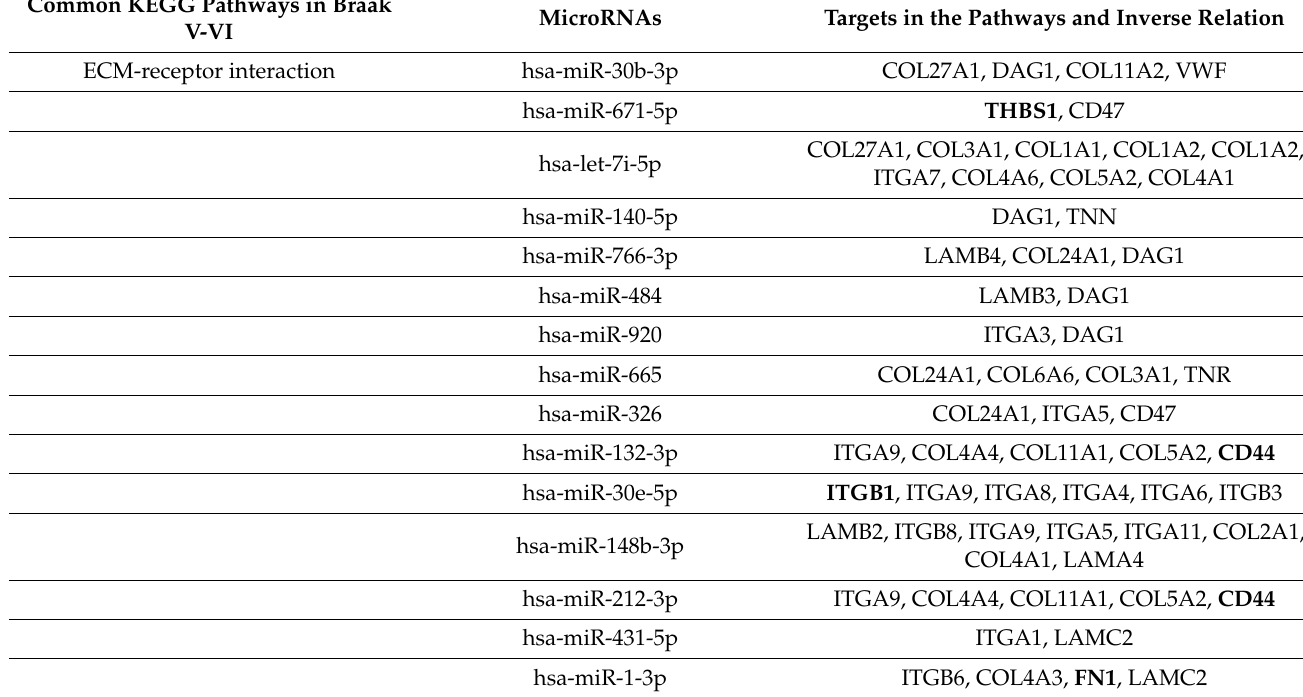
Table 5. Common pathways identified in DE-miRNAs and DE-proteins in Braak stage V-VI. For each of the pathways, the involved microRNAs and the correspondent predicted targets are listed. The protein targets identified in this study with an inverse relation are in